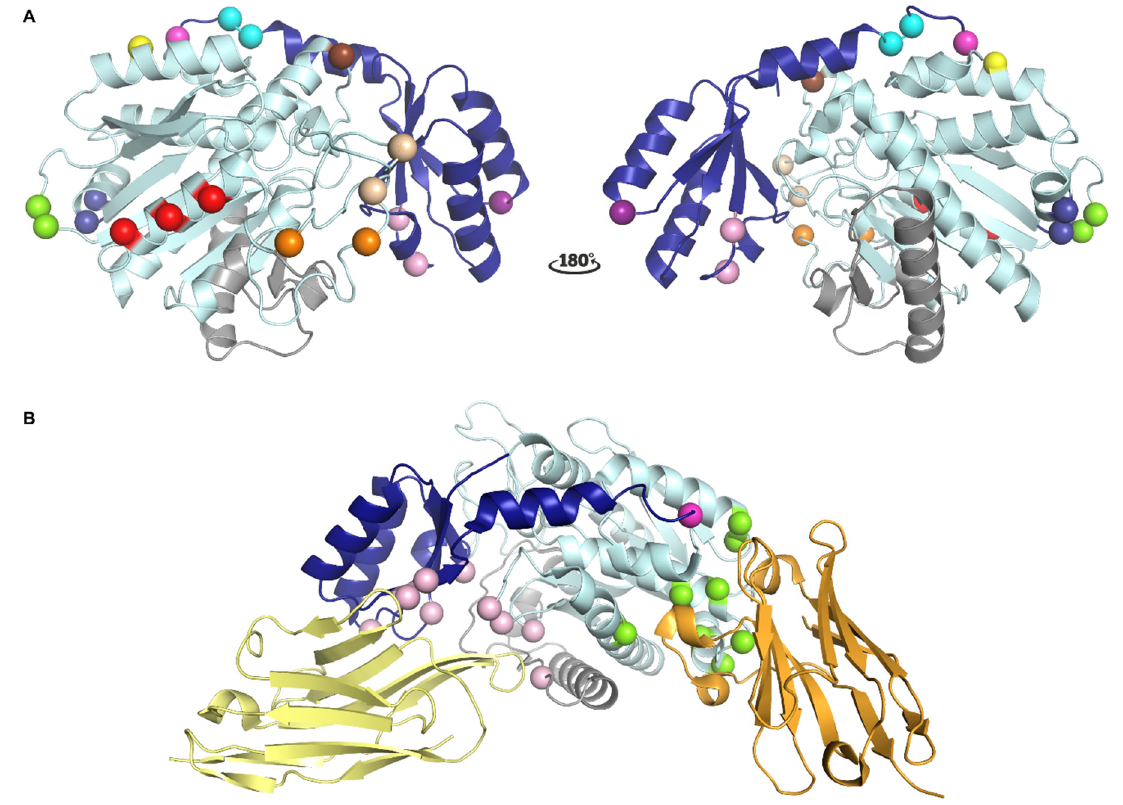
Figure 2. Localization of different epitopes in the structure of TAFI. ( A ) Localization of the epitopes of monoclonal antibodies (mAbs) that interfere with TAFI or TAFIa as determined by mutagenesis studies. The activation peptide (AP) and the catalytic moiety are colored in dark and light blue, respectively. The dynamic flap region is colored in grey. Major determinants of the epitopes are indicated as spheres. The cleavage site at Arg92 is indicated as a magenta sphere. Epitope residues for MA-RT36A3F5 and MA-RT13B2 are indicated by dark blue and light orange spheres, respectively. Epitope residues for MA-RT30D8 and MA-RT82F12 are indicated by the light and dark orange spheres. Epitope residues for nanobody VHH-mTAFI-i49, which destabilizes the TAFI proenzyme, are indicated by the brown and light orange sphere indicated by an asterisk. The epitope residue identified for MA-TCK27A4, which interferes with all modes of TAFI activation, is indicated by a yellow sphere. The epitope residue for MA-T12D11, which selectively inhibits T/TM-mediated TAFI activation, is indicated by a purple sphere. Epitope residues for MA-T94H3 and MA-T1C10, which interfere with both T/TM- and plasmin-mediated TAFI activation, are indicated by pink spheres. Epitope residues for MA-TCK22G2, which interferes with plasmin- and thrombin-mediated TAFI activation, are represented by green spheres. Epitope residues for MA-TCK11A9 and MA-TCK26D6, which mainly inhibit plasmin-mediated TAFI activation, are indicated by red and cyan spheres, respectively. Panel A was generated using the structure of intact human TAFI (PDB ID 3D66). ( B ) Cartoon representation of the crystal structure of TAFI in complex with nanobodies VHH-i83 (yellow) and VHH-a204 (orange) (PDB ID 5HVH). Residues that are engaged in polar interactions with VHH-i83 and VHH-a204 are indicated by pink and green spheres, respectively. The cleavage site at Arg12 is indicated as a magenta sphere.